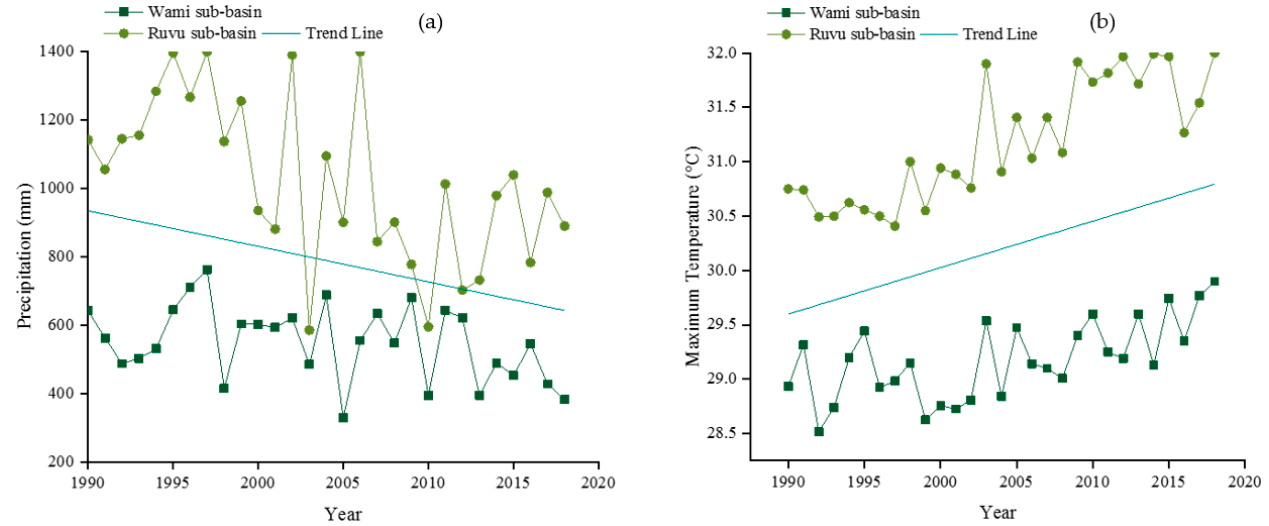
Figure 8. ( a ) The annual precipitation and ( b ) the annual temperature for the sub-basins of the WRB.